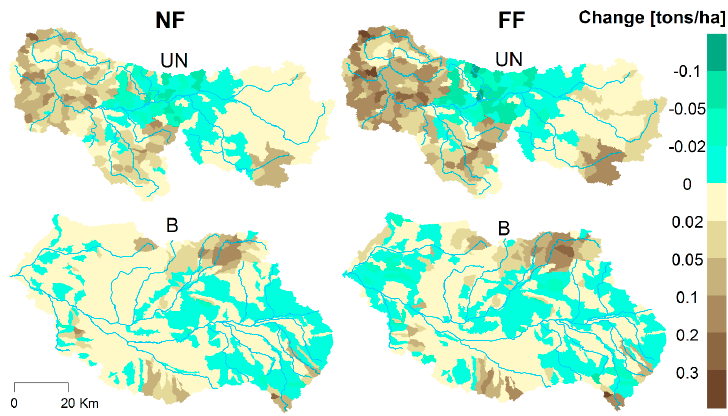
Figure 11. Projected change in sediment losses (total amount of sediment transported from sub-basins to streams) in the Upper Narew and Barycz catchments in the near and far future according to the ensemble median.